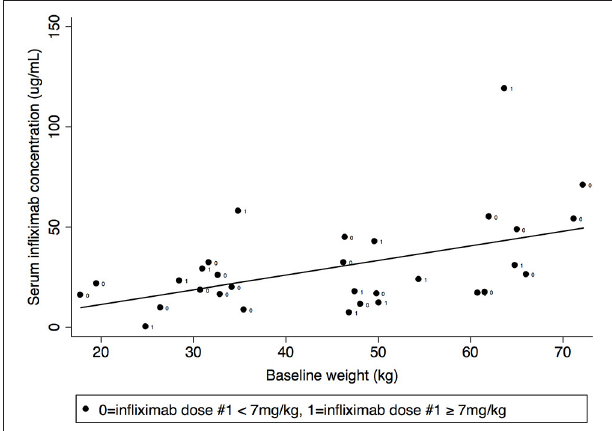
FIGURE 4 | Pre-dose #3 trough serum infliximab concentration by baseline subject